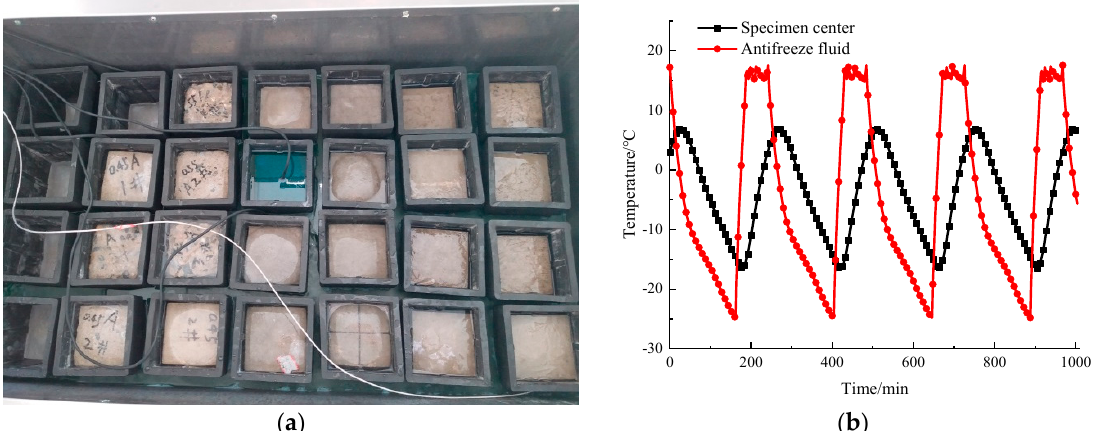
Figure 3. Rapid freeze–thaw testing machine and temperature change curve. ( a ) Rapid freeze – thaw testing machine, ( b ) Temperature change curve.